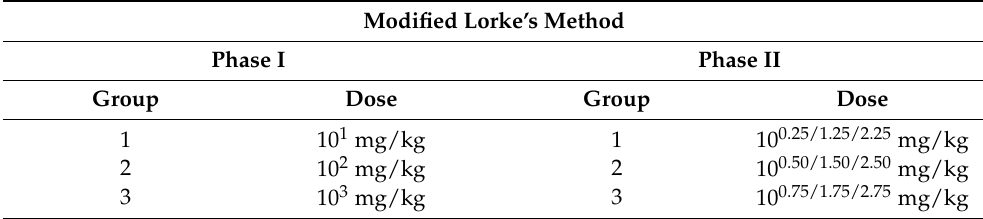
Table 2. Modified Lorke’s method organization for estimating LD 50